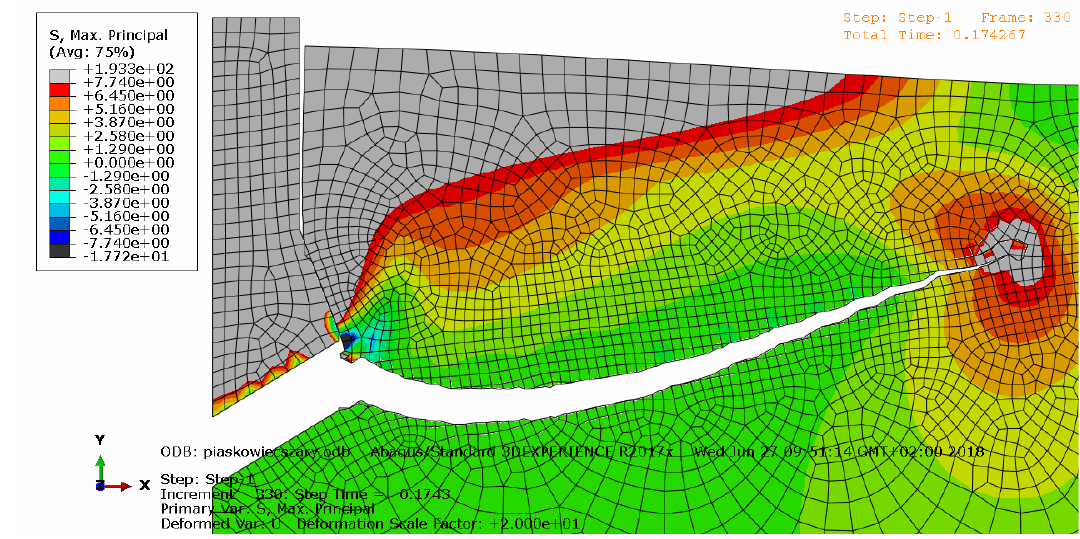
Figure 10: Last step of calculation from simulation with anchor and friction coefficient µ =